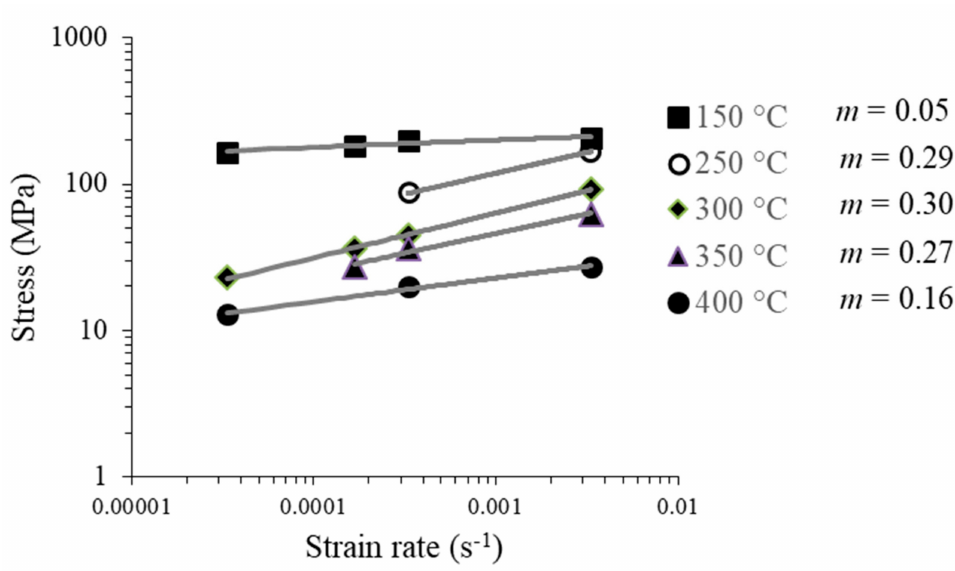
Figure 10. Maximum stress versus strain-rate for di ff erent temperatures and their respective m coe ffi cient for samples processed by two RCS